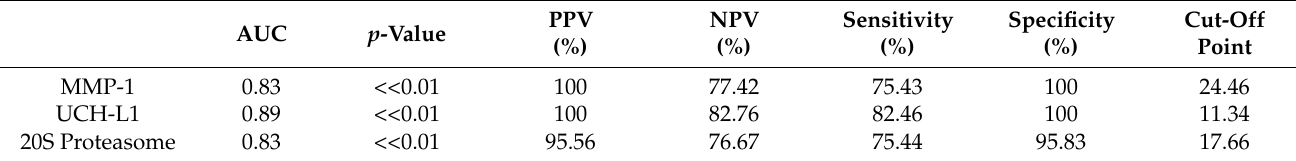
Figure 4. Graphs of changes in the concentrations of ( A ) MMP-1, ( B ) UCH-L1, and ( C ) 20S proteasome depending on the grade of the disease and in the control group. Table 4. Data on the diagnostic performance of the tested